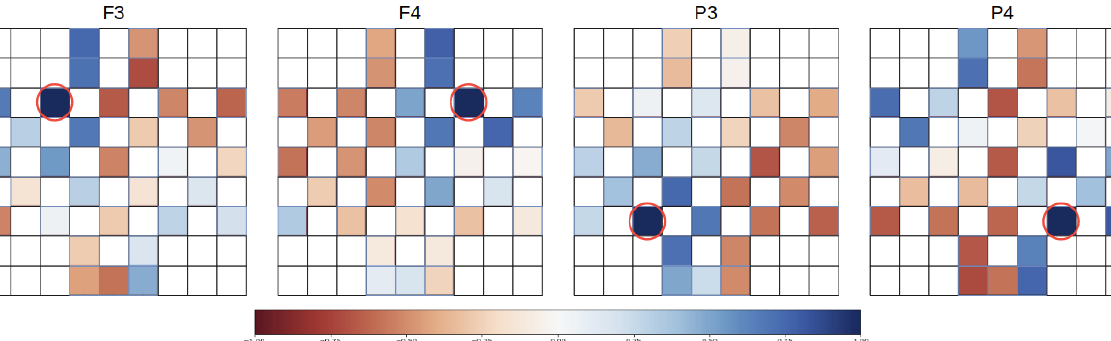
Figure 4. The architecture of each multi-scale kernel convolution block in the network.